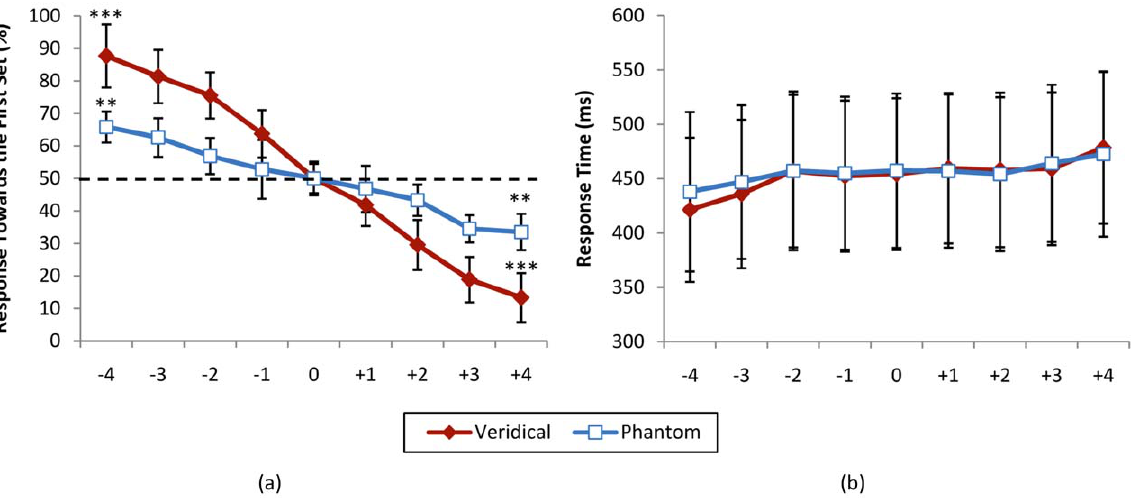
Figure 4. Psychometric function for the duration judgement task. (a) Percentage response towards the first set and (b) response time for veridical ( t 1 ? t 2 , n 1 = n 2 ) and phantom ( t 1 = t 2 , n 1 ? n 2 ) conditions. Horizontal axis shows different levels of comparison ( t 2 2 t 1 for veridical and n 2 2 n 1 for phantom trials). *** p , 0.001, ** p , 0.005. Error bars reflect one standard deviation.